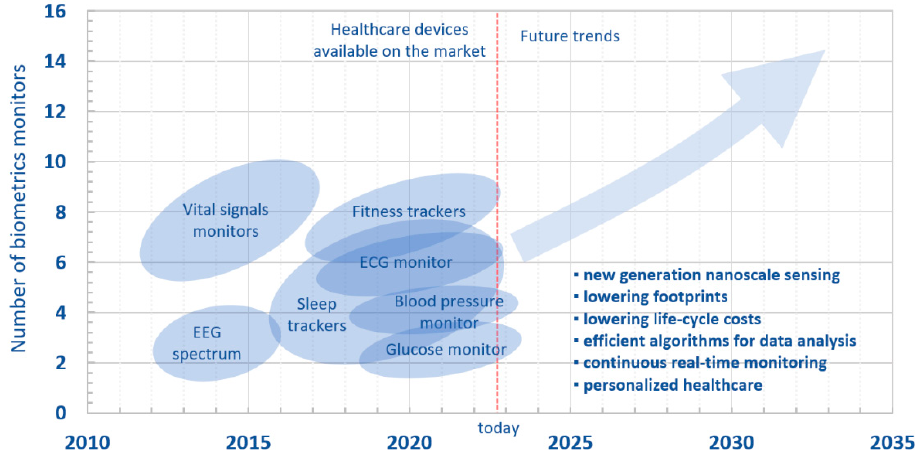
Figure 16. Roadmap of sensing devices for healthcare.